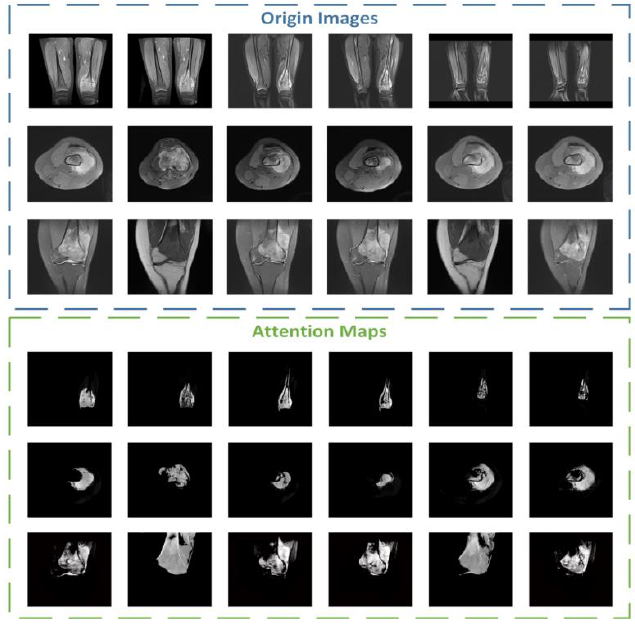
Figure 11. Some examples of attention maps from